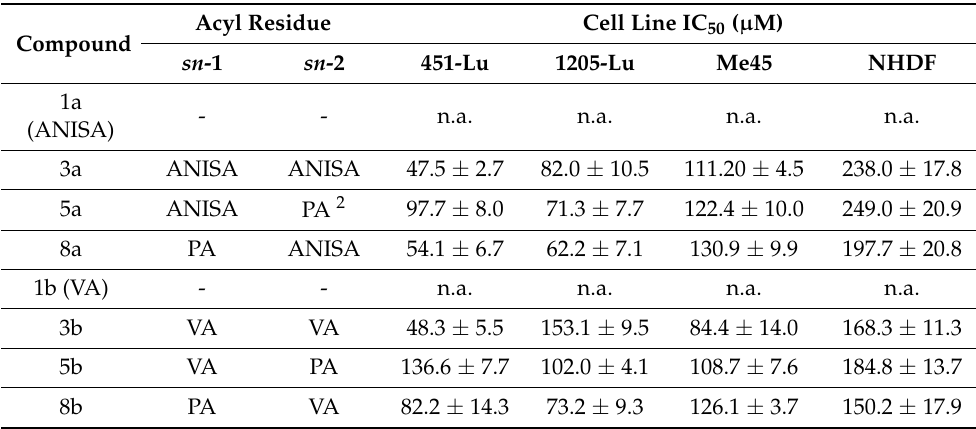
Table 1. The half maximal inhibitory concentrations (IC 50 ) of studied compounds in metastatic melanoma cells (451-Lu, 1205-Lu and Me45) and normal skin fibroblasts NHDF. Acyl Residue Cell Line IC 50 ( µ M) Compound sn -1 sn -2 451-Lu 1205-Lu Me45 NHDF 1a n.a. (ANISA)